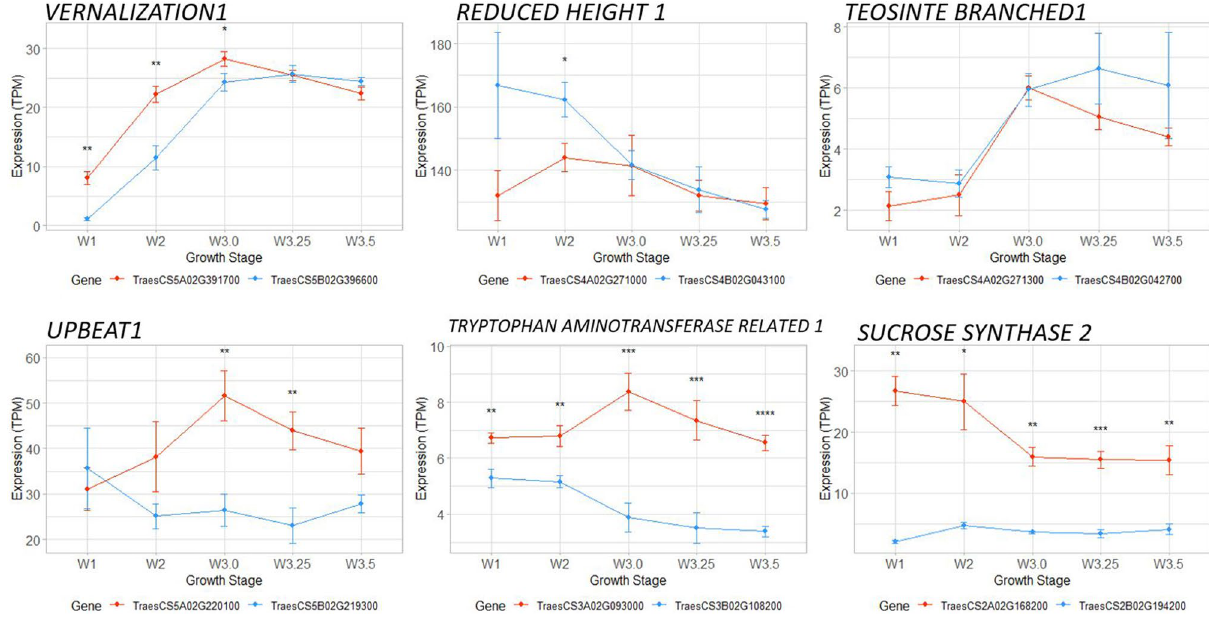
Figure 4. Divergent expression of homoeologous gene pairs during inflorescence development. Examples include the expression profiles of characterized domestication and adaptation alleles and genes close to QTL for spike architecture or grain size. Expression values are in TPM ± standard error. A-genome homoeologs are in orange, B-genome homoeologs are in blue. Paired t-tests were used to indicate differences between homoeolog expression at each time point, P values < 0.05 (*), 0.01 (**), 0.001 (***), 0.0001